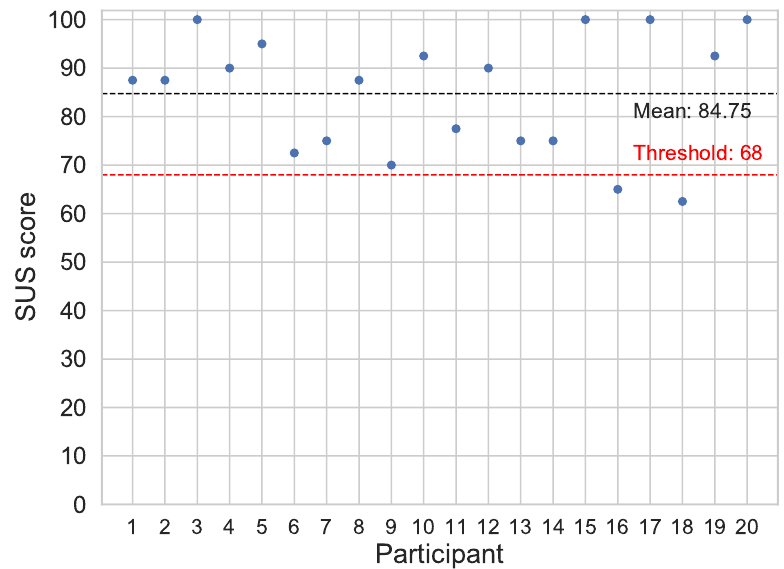
Figure 12. System Usability Scale (SUS) score obtained from each participant. The horizontal lines represent the mean SUS score of the system and the threshold value that indicates a good